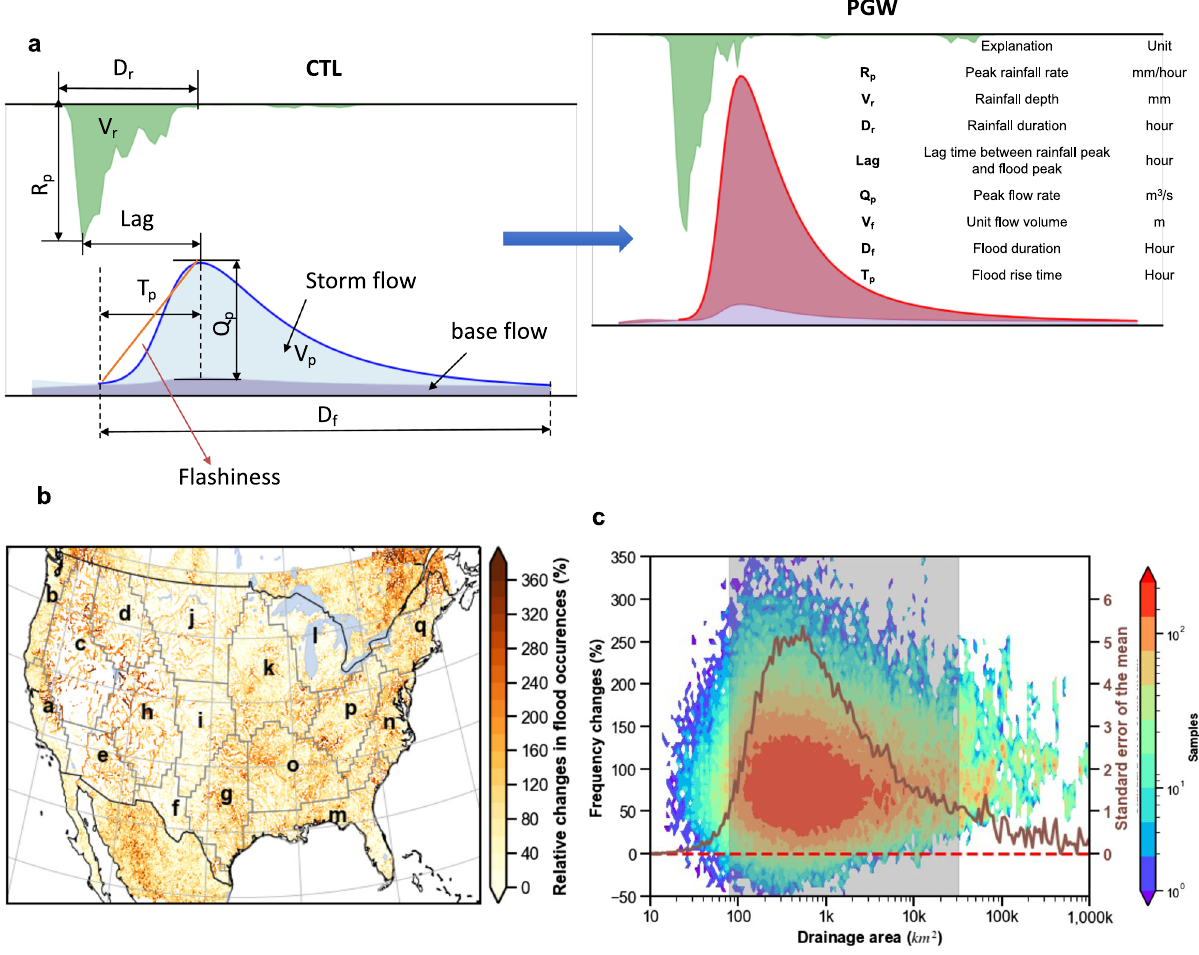
Fig. 1 Schematic view of rainfall-runoff event association at US HUC8 catchment scale. a illustration of calculated fl ood characteristics; b the percentage change of fl ood occurrences comparing the future (PGW) and retrospective analysis (CTL) at 1-km spatial resolution; c conditional plot of frequency changes against drainage area (shaded contour plot) and standard error of the mean in dark red line. Maps and fi gures are produced using the Python package Matplotlib and